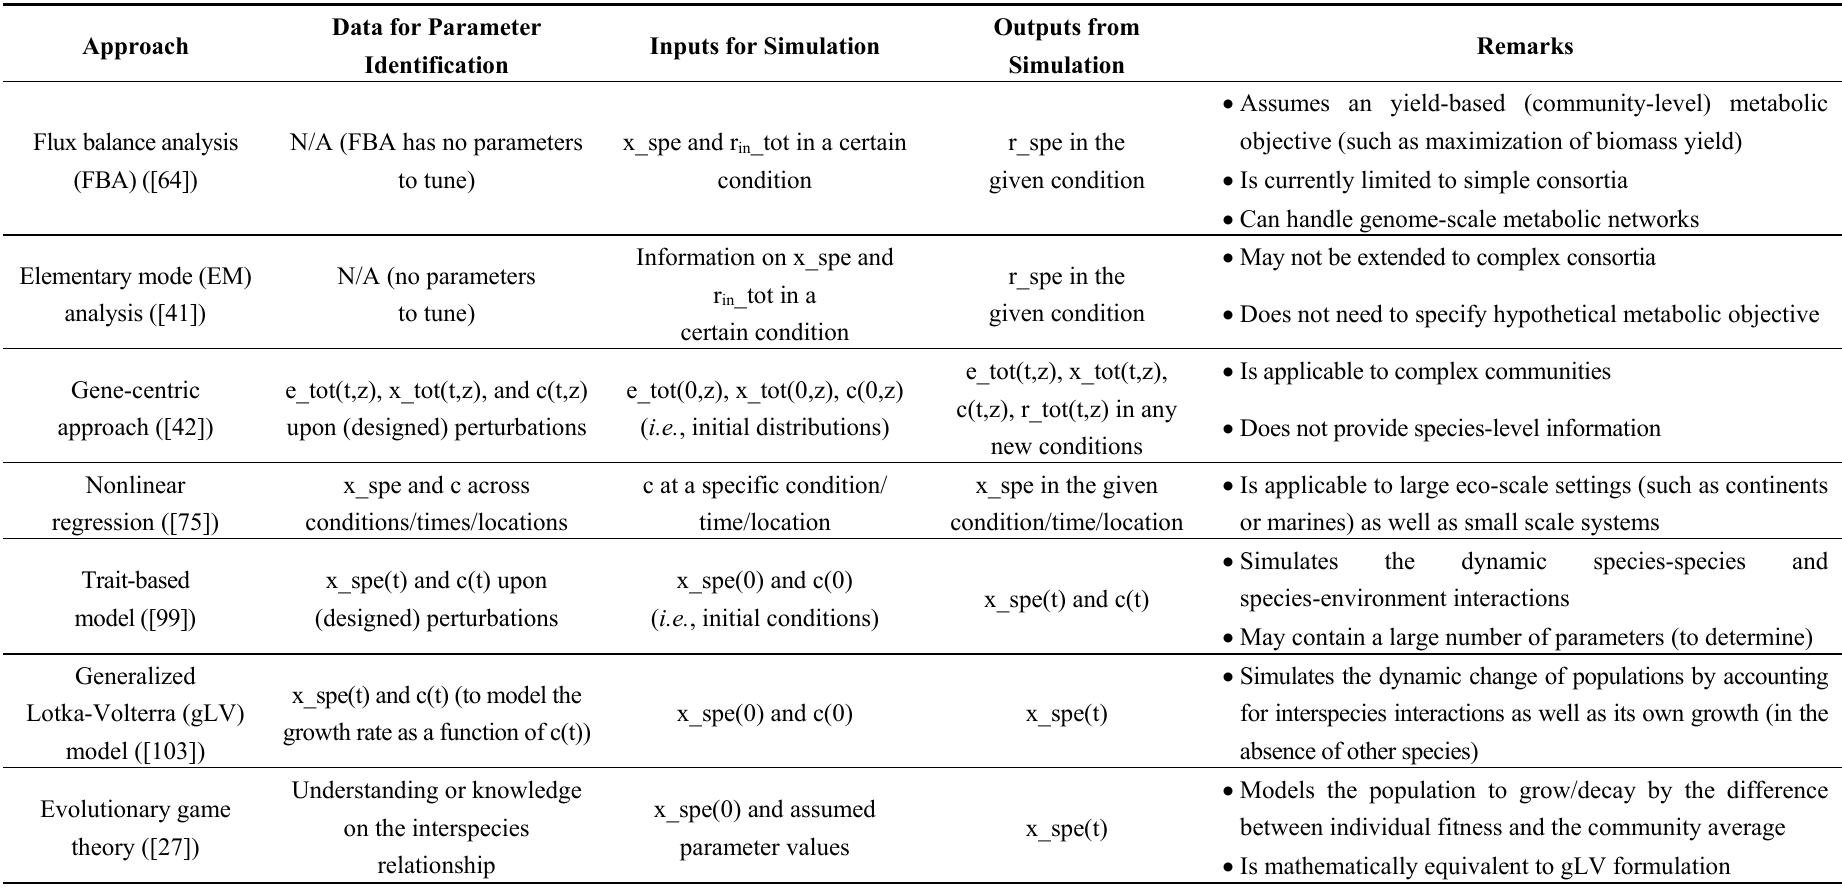
Table 2. An overview of mathematical models discussed throughout the present article. Symbols denote modeling units (_cell: Individual cells, _spe: Species or functional guilds, _tot: Whole community), dependent variables (c: Concentration of extracellular metabolites, e: Abundance of functional genes, r in : Uptake fluxes, r: Full flux vector including intracellular and exchange fluxes, x: Abundance of modeling units) and independent variables (t: Time, z: Spatial